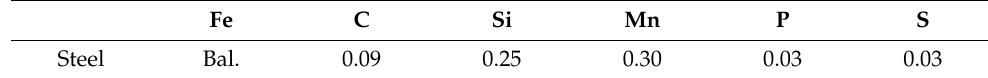
Table 2. Chemical constitutions of steel sheet